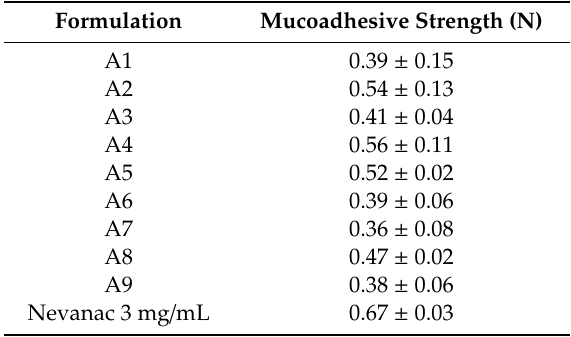
Table 5. Mucoadhesive strength of ophthalmic formulations on ex vivo bovine